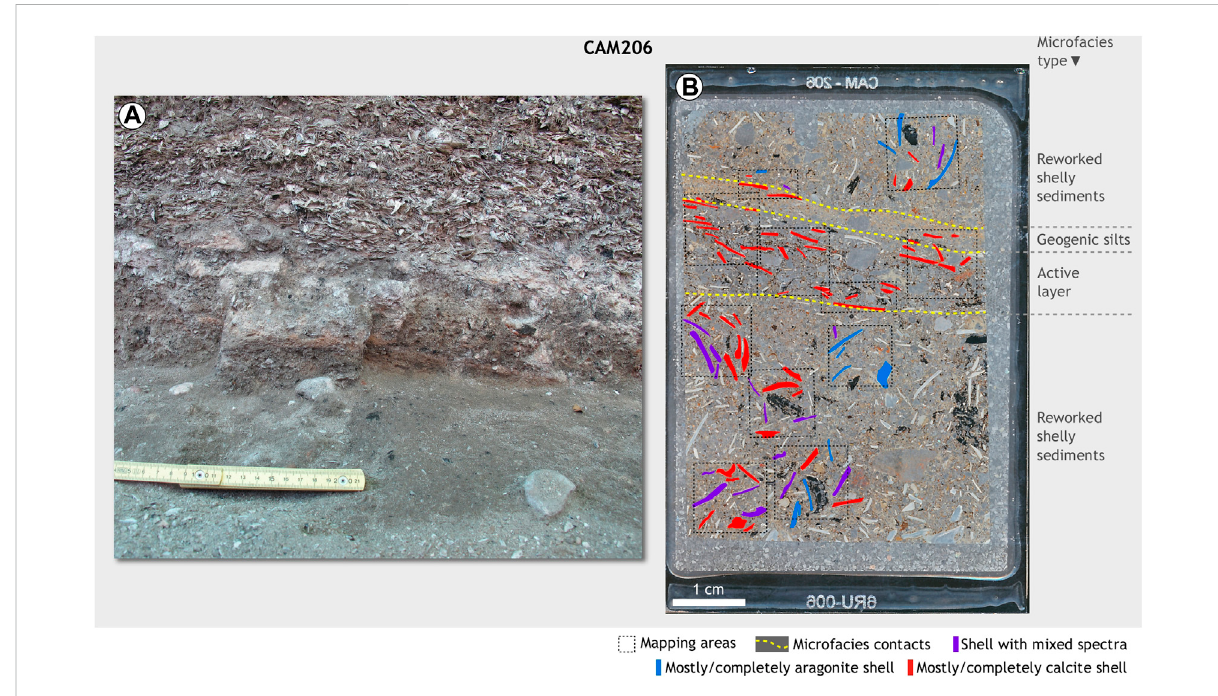
FIGURE 7 SampleCAM206: (A) Fieldphotographofthesampleinpro fi le,priortoblockextraction. (B) Thinsectionscanofthesamplesshowingindividual shells ’ overall mineralogy obtained through